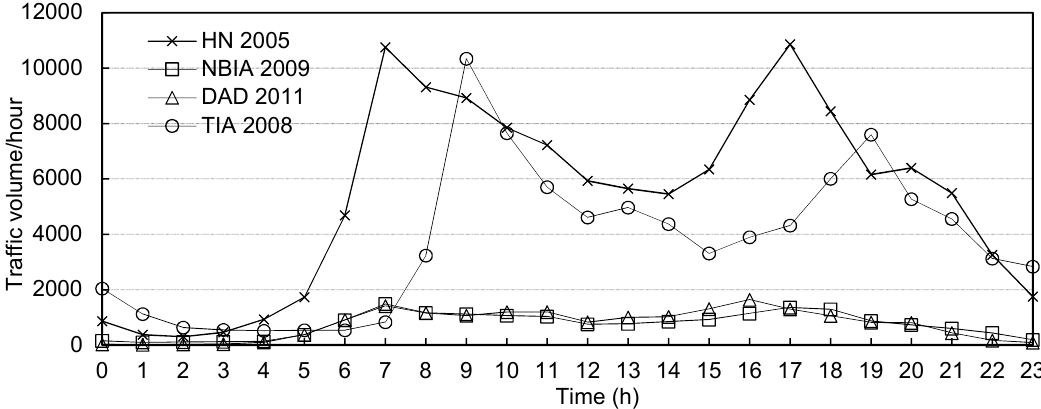
Figure 2. Hourly average road traffic volume in the day (24 hours) observed in Hanoi downtown (2005) and at sites near NBIA (2009), DAD (2011), and TIA (2008).